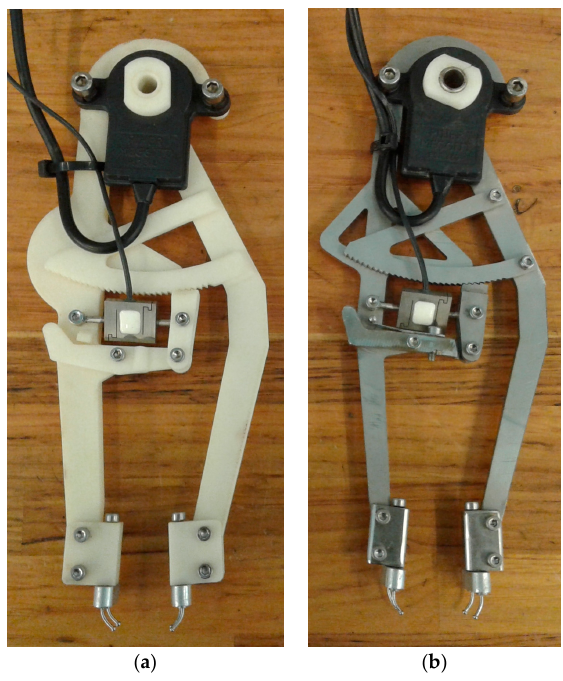
Figure 5. Prototypes of the instrument built: ( a ) 3D printed plastic; ( b ) stainless steel.